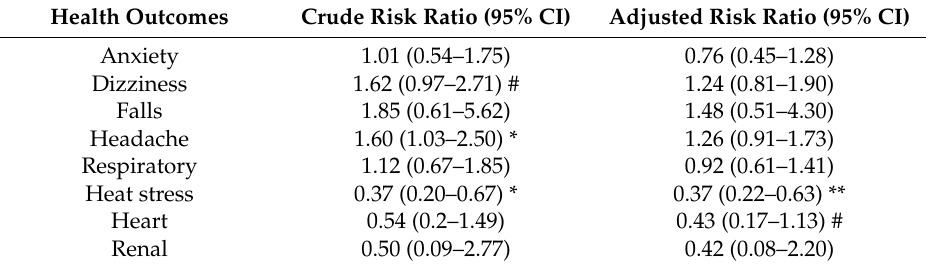
Table 5. Crude and adjusted risk ratios and 95% Confidence Intervals (95% CI) expressing the health outcomes in the intervention compared to the control group. For adjustment, the following confounders from Table 2 were included: mental health-related medication, health status and use of aids for